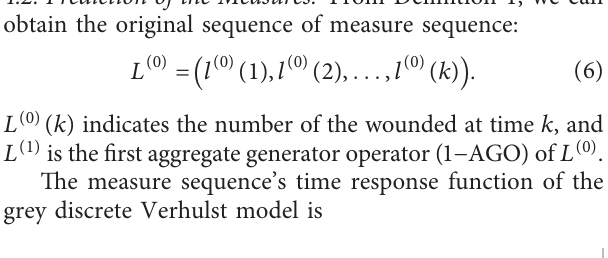
kernels and measures sequences are solved by Definition 2.